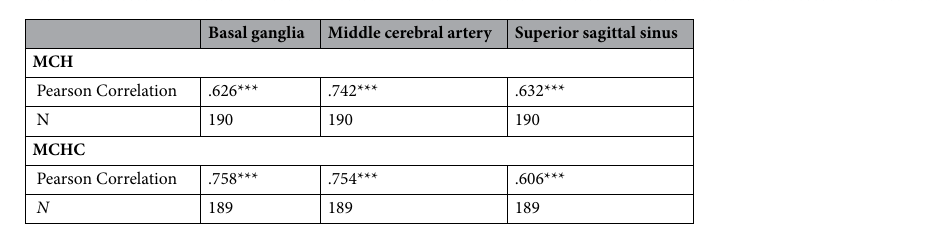
Figure 2. Scatter plot revealed a positive correlation between the CT values of basal ganglia, the middle cerebral artery, and the superior sagittal sinus and MCH and MCHC in all patients of the two groups.